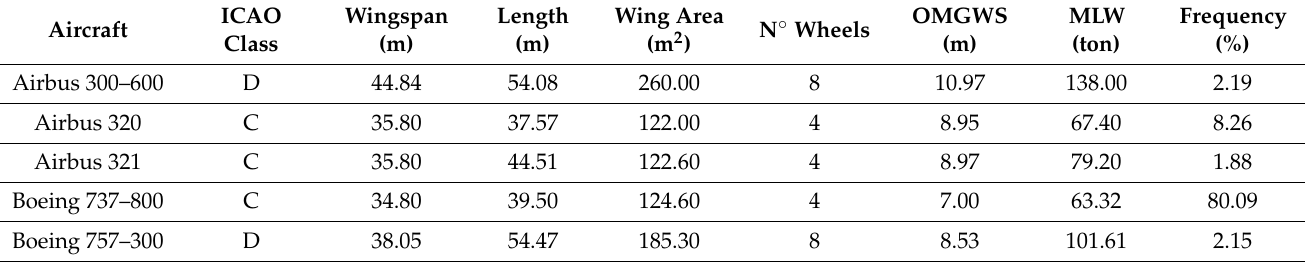
Table 5. The main characteristics of the most frequent operating aircraft at selected airport.